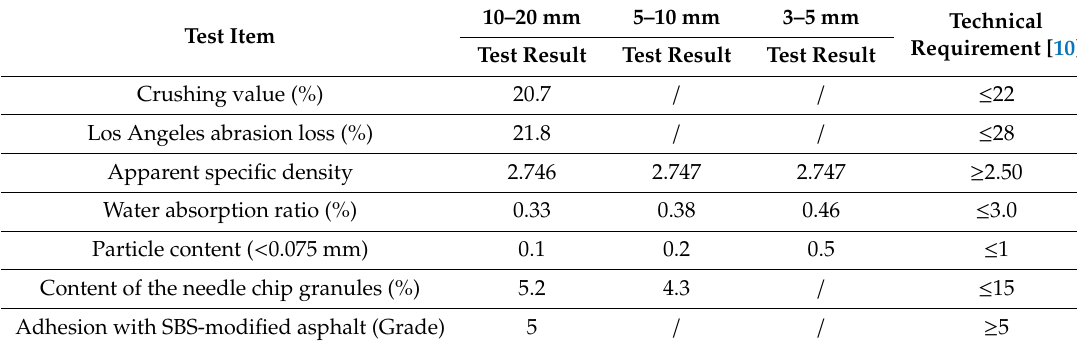
Table 2. Properties of coarse mineral aggregate.